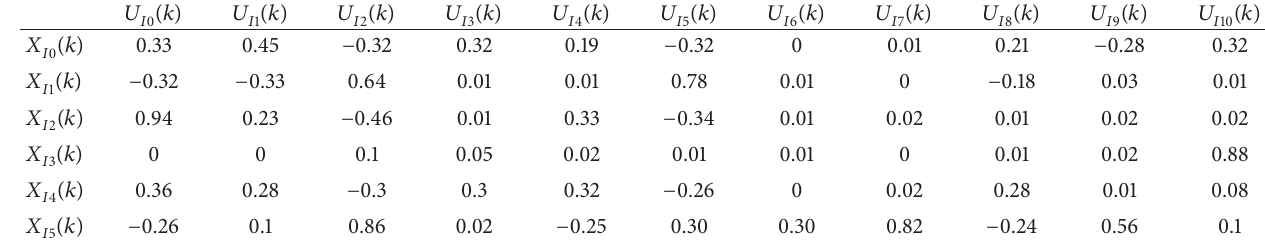
of the sensitivity of conscious reaction. OF